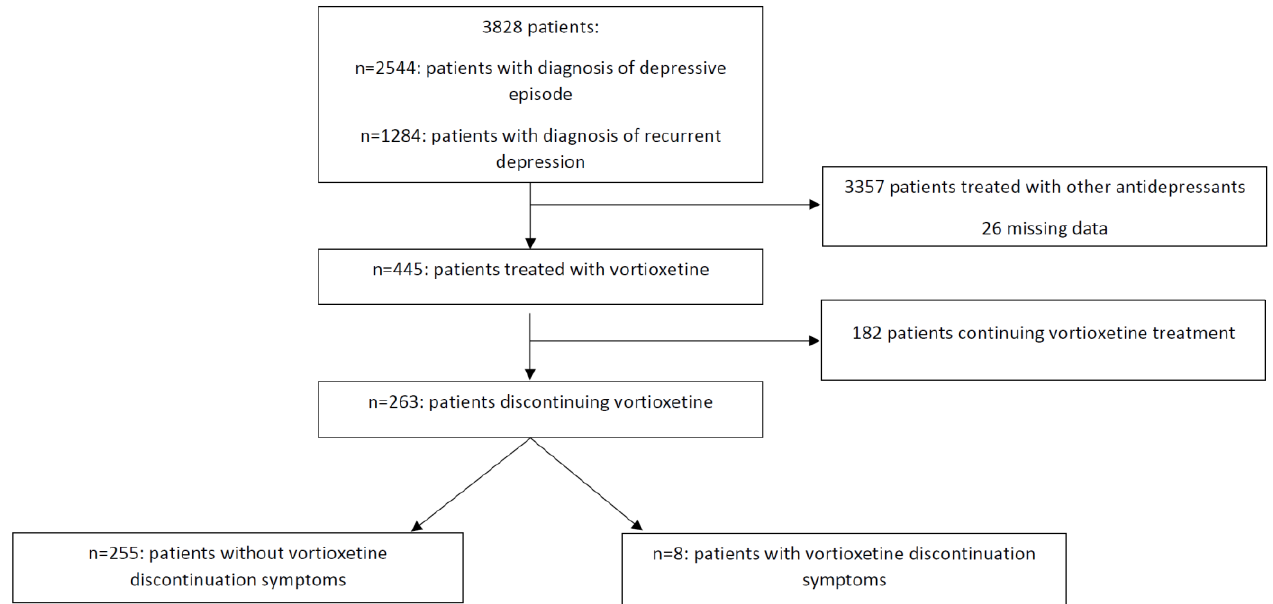
Figure 1. Flow chart of retrospective chart review.